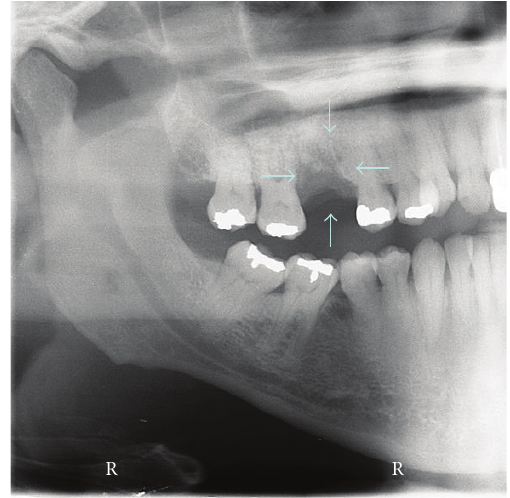
Figure 3: Case 2. Lytic lesion right maxilla.